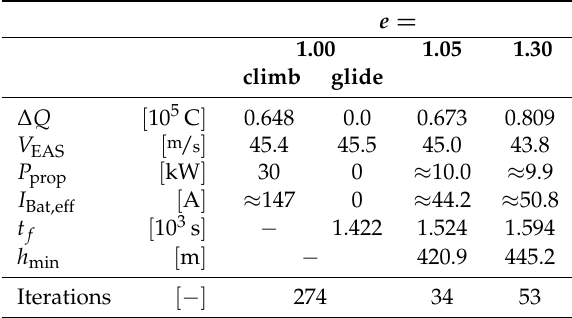
Table 1. Quantitative Comparison of Values in the three